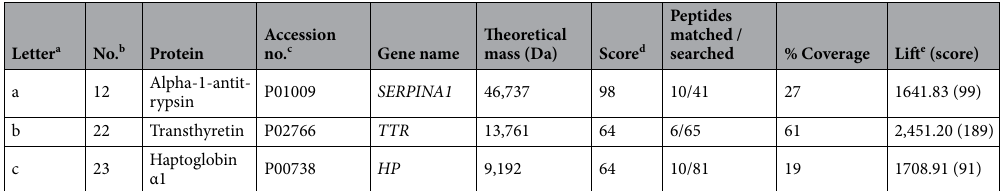
Table 2. Proteins differentially detected in plasma samples of HF and HDF patients identified by MALDI- TOF MS. a Proteins identified by MALDI-TOF MS were named with letters according to differential protein detection in fluorescence-labelled experiments (Fig. 1), and in b were named with the corresponding numbers in unlabelled and Coomassie blue-stained experiments (Fig. 2). c Accession number in UniProt database (https ://www.unipr ot.org). d Protein identification scores > 56 were significant ( p < 0.05) in the MASCOT database search algorithm. e MALDI LIFT-TOF/TOF MS identification mode; the m/z of the fragmented parental peptide is indicated; MASCOT scores (in parenthesis) > 28 were significant ( p < 0.05).